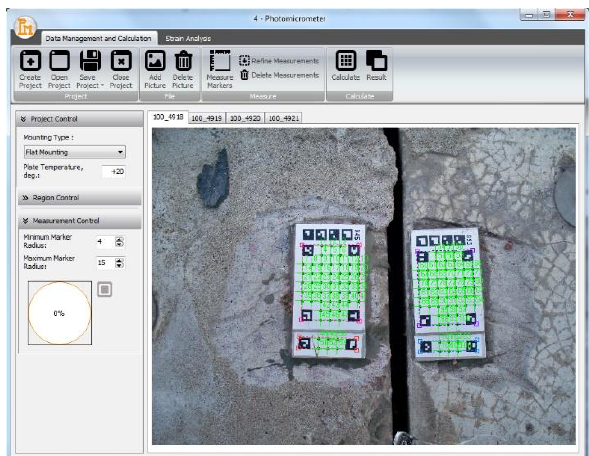
Figure 9. Automatic measurement of the marks